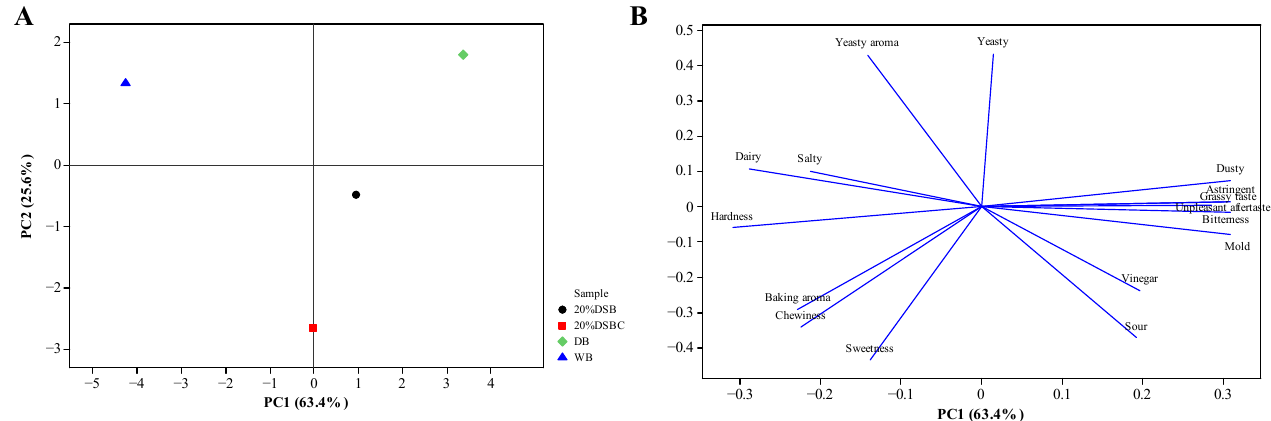
Figure 3. Descriptive analysis of different bread samples. ( A ) Score plot and ( B ) loading plot of different bread samples. PC1 explained 63.4% of the variation in the data. WB (wheat bread) is marked in blue, DB (djulis bread) in green, 20% DSB (djulis sourdough bread) in black, 20% DSBC (djulis sourdough bread with cocoa power and dried cranberry) in red, and attributes are marked in blue. Table 6. Affective analysis of the different bread samples.